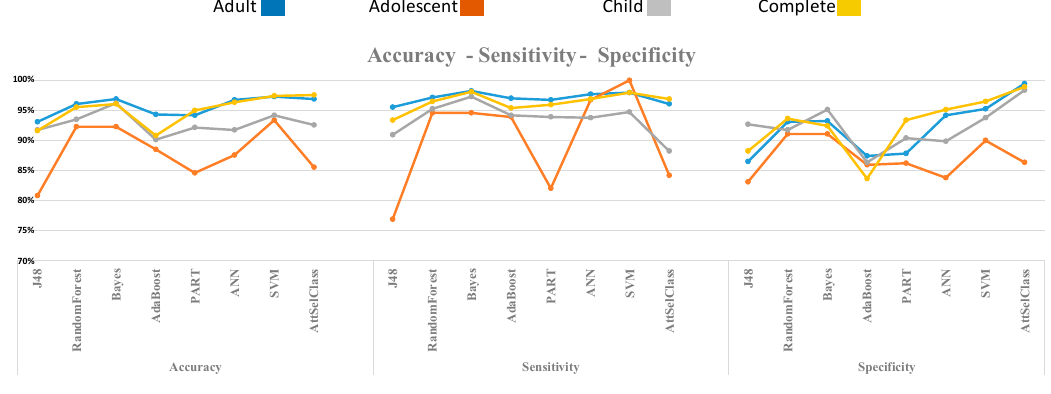
Table 2. Definition of confusion matrix.